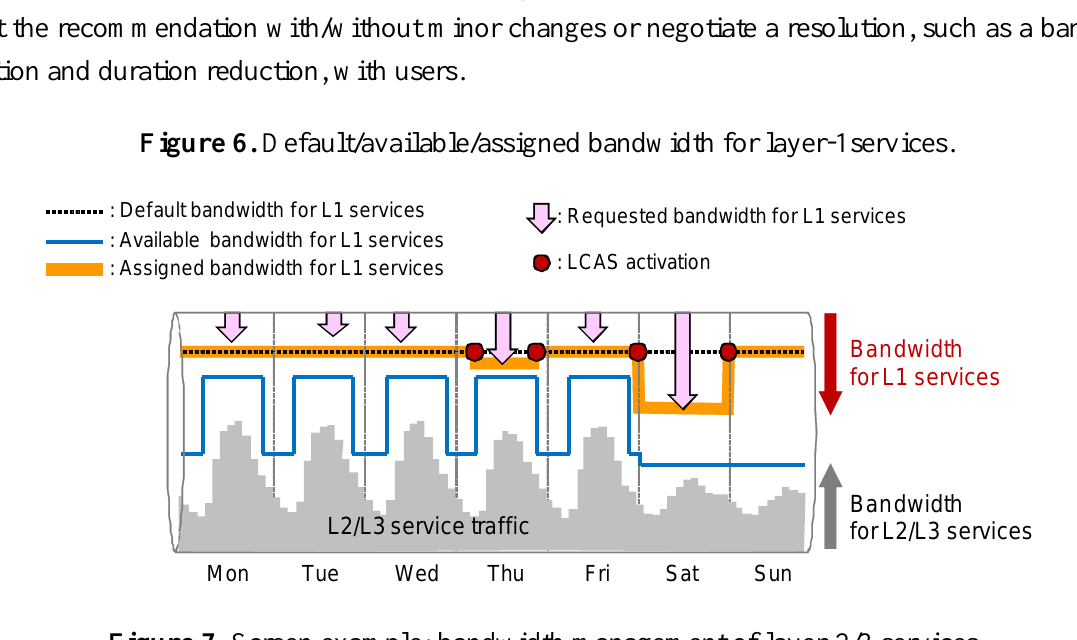
Figure 7. Screen example: bandwidth management of layer-2/3